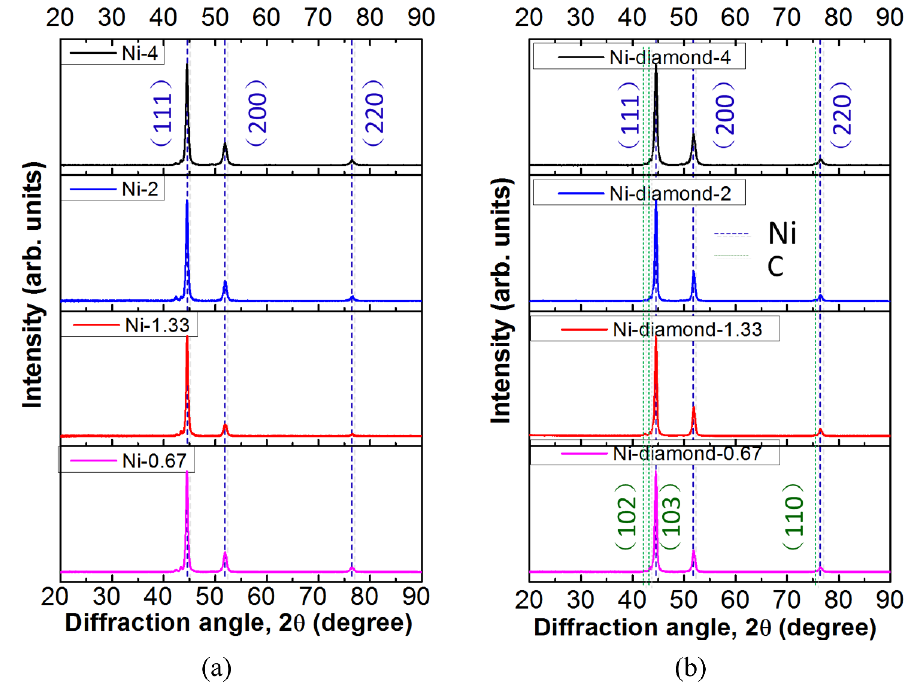
Figure 4. XRD spectra. ( a ) Ni coating; ( b ) Ni–diamond coating.